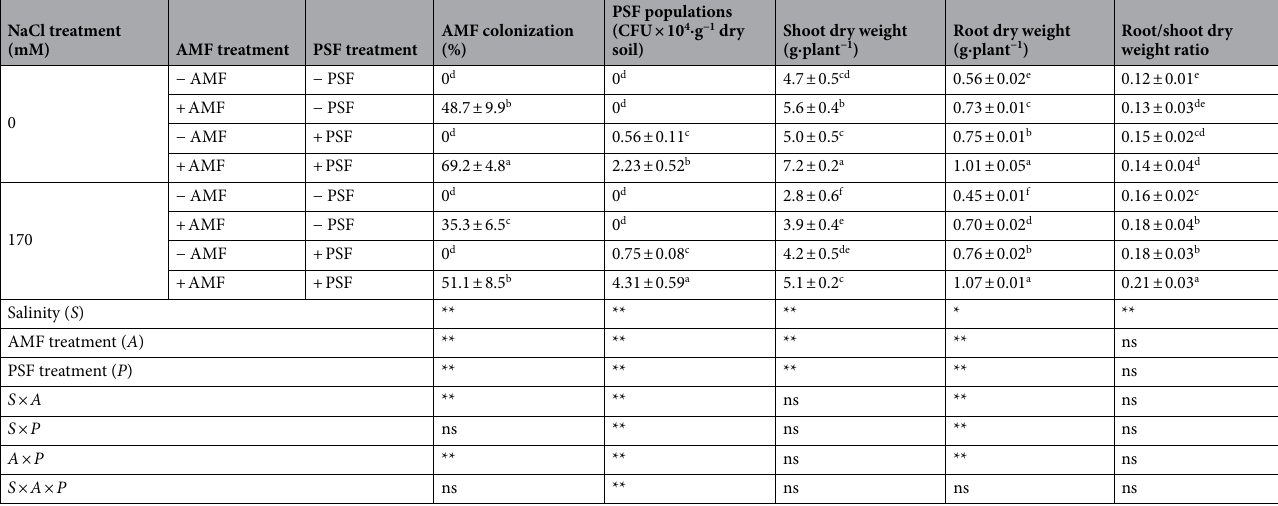
Compared to non-inoculated plants, inoculation with AMF, PSF, or both significantly improved N concentra- tions regardless of NaCl stress (Fig. 1, p < 0.01). N accumulation was higher in shoots than in roots of the same inoculation treatment (Fig. 1, p < 0.01). Among NaCl-treated plants, co-inoculated plants showed the highest N concentrations in the roots and shoots, and the total N content also supported this result. Salinity exhibited no significant effects on N contents in the shoots or roots of non-inoculated or singly inoculated plants ( p > 0.05). NaCl stress reduced K contents in the roots but stimulated accumulation in the shoots compared to unstressed plants (Fig. 1). Inoculation with AMF, PSF, or both significantly promoted K accumulation in the roots and shoots regardless of salt stress ( p < 0.05). Among NaCl-treated plants, PSF-treated plants showed the highest K concentration in the shoots (359.7 mg·kg −1 dry weight (DW)) and the lowest values in the roots (43.6 mg·kg −1 DW), and co-inoculated plants showed the highest total K concentrations (111.6 mg·kg −1 DW). Changes in photosynthetic parameters of beach plum under salt stress. The net photosynthetic rate ( P n ), stomatal conductance ( G s ), and transpiration rate ( E ) were higher in inoculated plants than in non- inoculated ones at 0 mM NaCl, while a lower intercellular CO 2 concentration ( C i ) value was observed in inocu- lated plants. Salinization caused significant ( p < 0.05) reductions in P n , G s , and E values and a lower C i value, while inoculation with AMF, PSF, or both significantly abated such reductions ( p < 0.05, Fig. 2). The most effec- tive treatment was inoculation with AMF and PSF, and the AMF inoculation treatment yielded P n, G s , C i , and E values close to the PSF inoculation treatment ( p < 0.05, Fig. 2). Among NaCl-treated plants, plants co-inoculated with AMF and PSF had the highest P n , G s , and E values (increased by 152.1%, 272.7%, and 94.3% compared to only NaCl stress, respectively) and the lowest C i value (decreased by 65.5% compared to only NaCl stress).